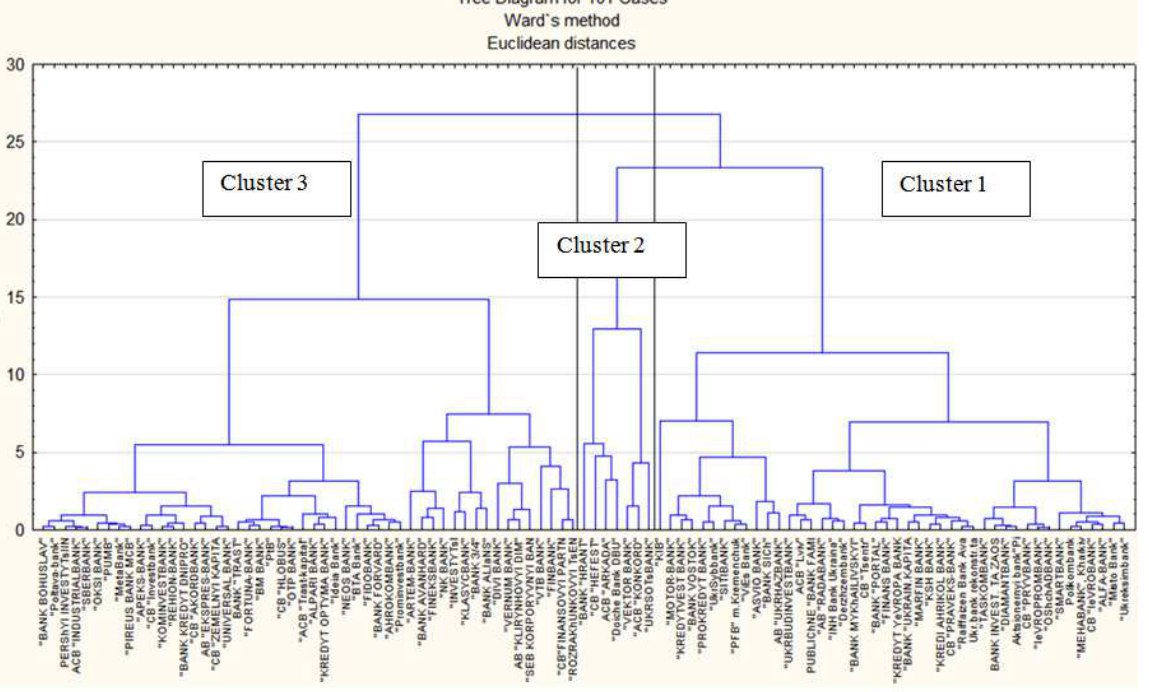
Fig. 2. The results of clustering Ukrainian banks using the Ward’s method Source: elaborated by the